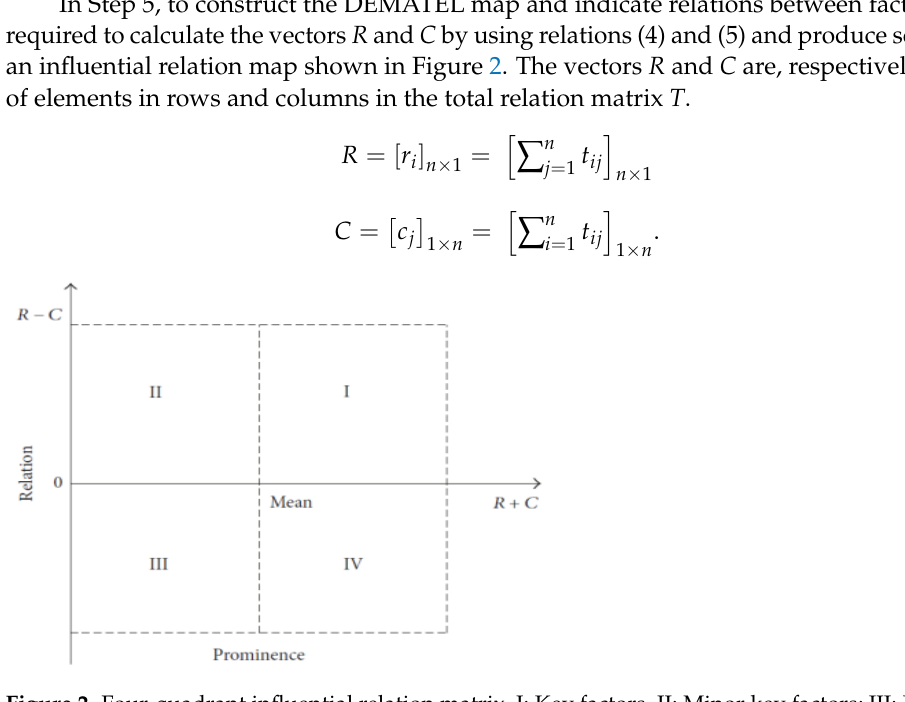
Figure 2. Four-quadrant influential relation matrix, I: Key factors, II: Minor key factors; III: Independent factors; IV: Indirect factors.